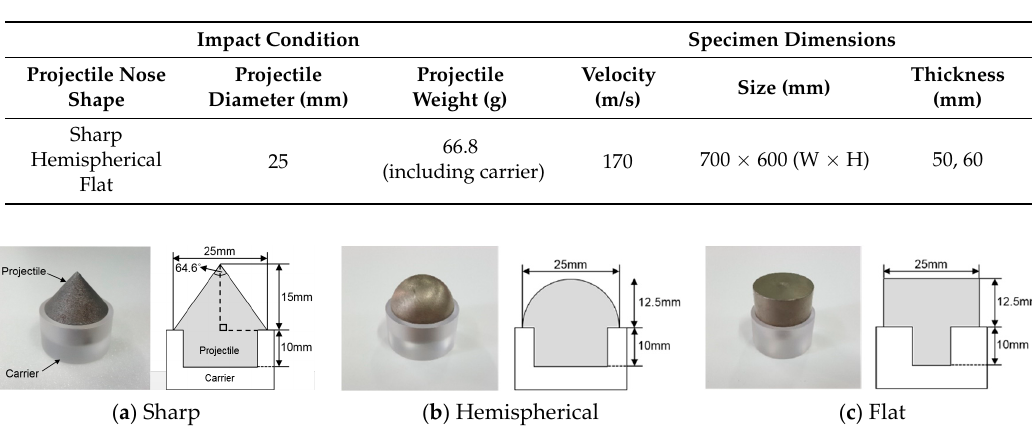
Table 2. Experimental design.